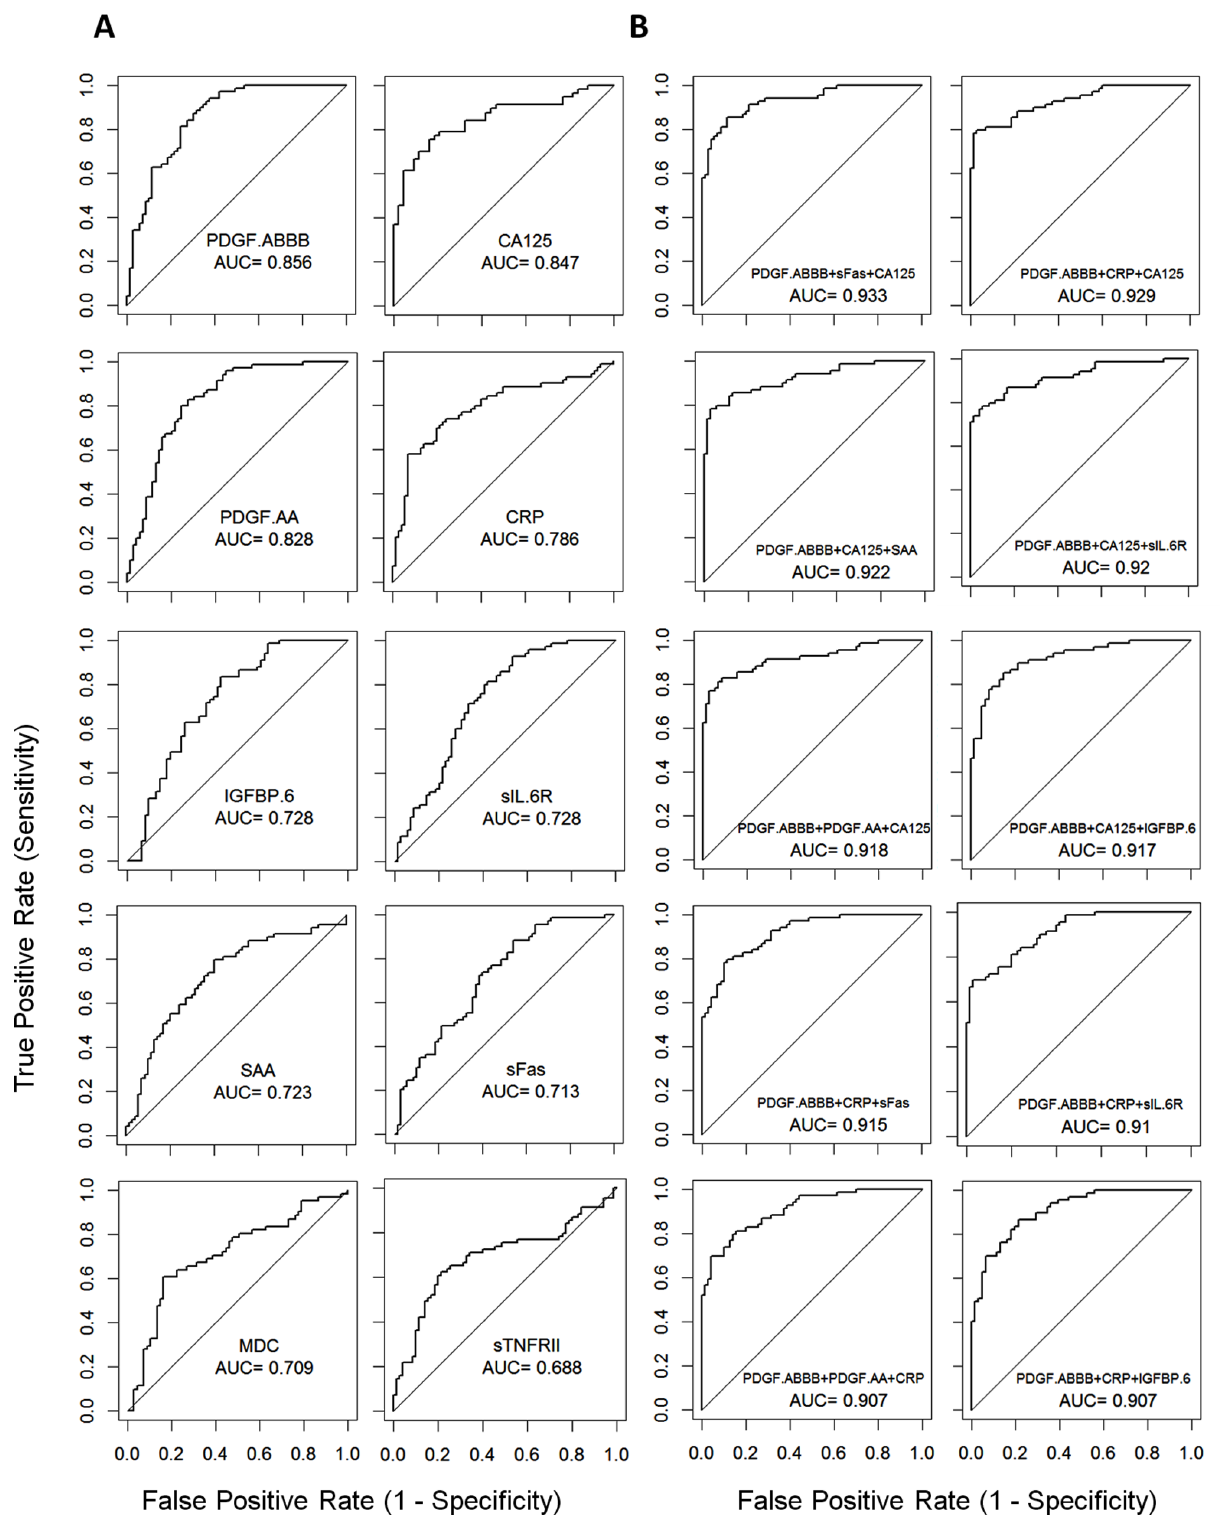
Figure 2. The ROC curves for the top molecules that can distinguish cancer patients (post diagnosis and recurrence) from healthy controls. Single proteins (A) and multi-marker models (B) were used for the classification analyses. For multi-marker models, linear discriminate analysis was performed using combinations of 3 proteins. The diagnostic performance of each model was evaluated using leave one out cross validation method. The utility of serum proteins as ovarian cancer biomarkers was evaluated using the area-under-curve (AUC) of the ROC curves for different models.